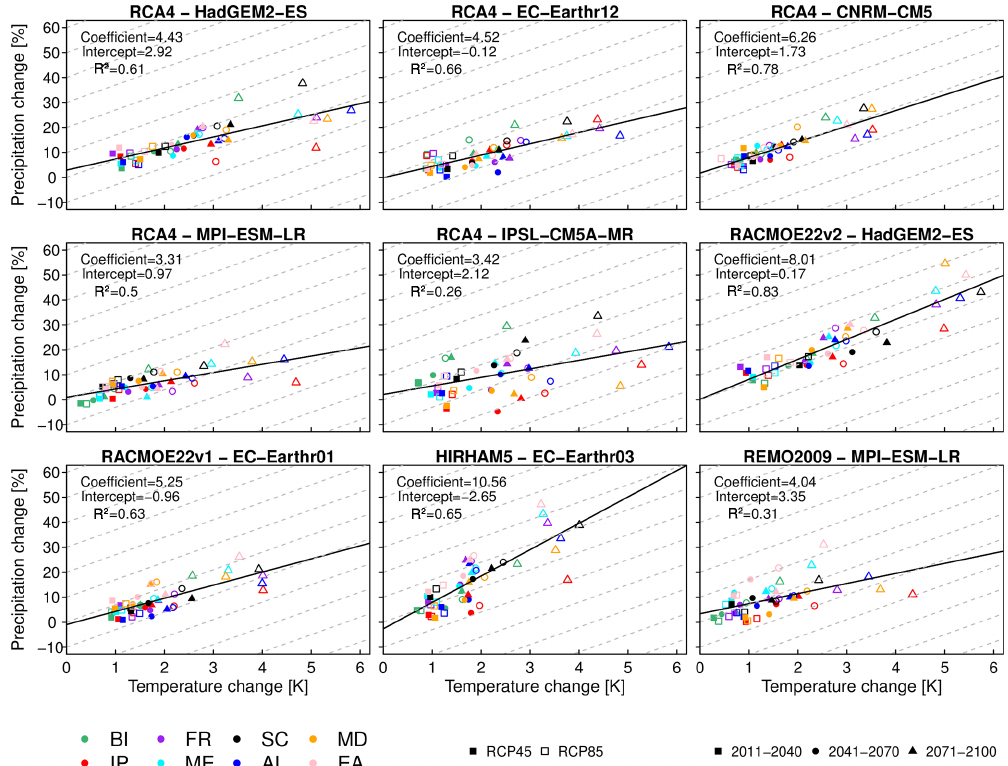
Figure 8. Scatterplot of the relative change in 10-year 12h depths against summertime mean temperature change between future and historical time periods, for different subregions, emission scenarios, and time periods according to the legend. Each panel shows the result for different RCM–GCM combinations. Linear fits to all data are presented in each panel, along with slope and intercept coefficients, as well as the R 2 value of the fit. CC-rate changes of 7%K − 1 are shown as grey lines in the